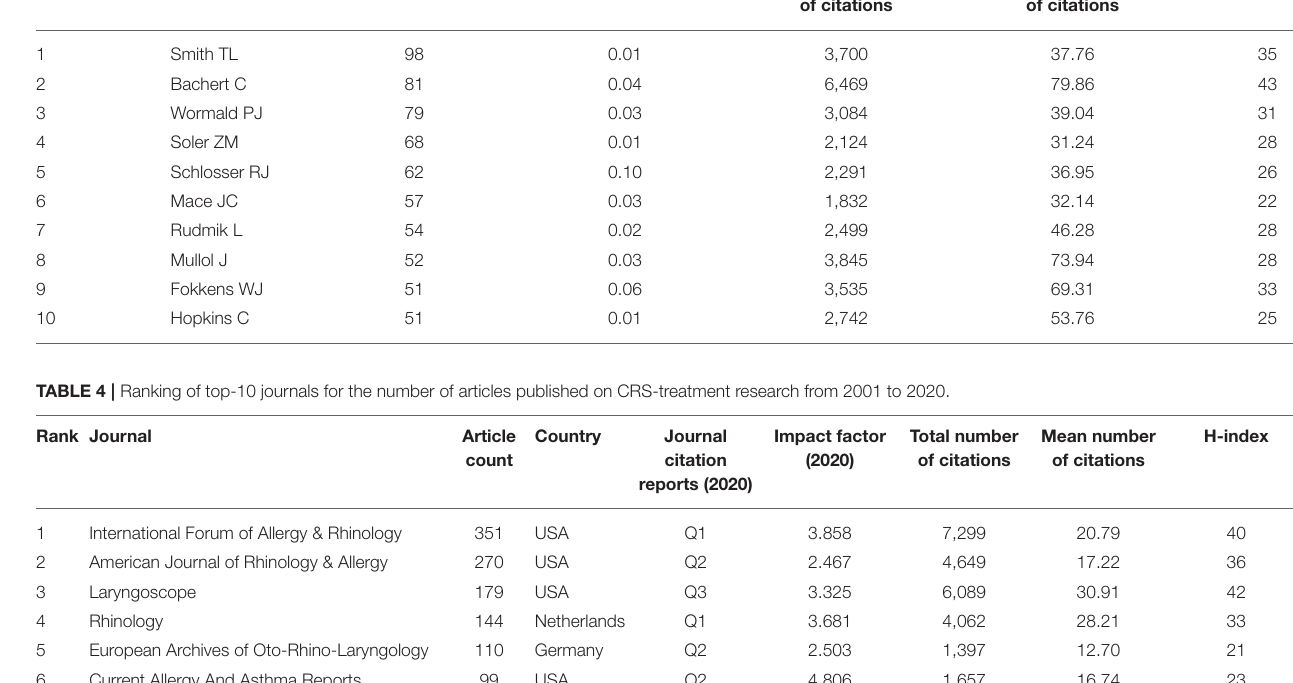
TABLE 3 | Ranking of top-10 most-published authors on CRS-treatment research from 2001 to 2020. Rank